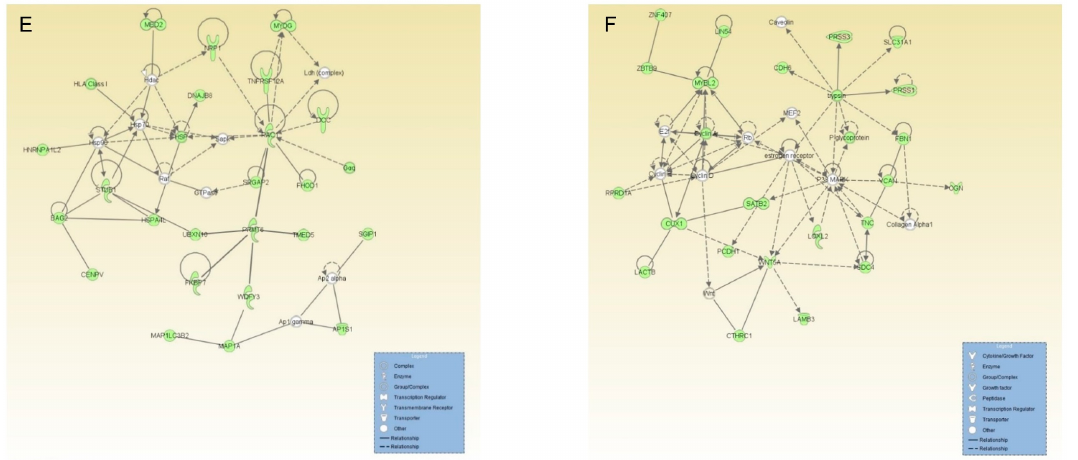
Figure 3. The SHED-specific proteome derived from nano-LC-MS/MS technology utilization. ( A ) Classification of the identified by nano-LC-MS/MS proteins that were exclusively expressed in SHEDs, using their role in general “Biological Processes” as the major criterion for bioinformatics clustering. The Gene Ontology (GO) sub-routine of DAVID software was the bioinformatics protocol applied. p < 0.05. ( B ) Heat map of the SHED-specific proteomic list, illustrating 137 proteins involved in cellular movement, migration and invasion. This SHED-specific heat map was created by using IPA. Each legend denotes respective function and p value: 1, Cell movement (8.211); 2, Cell movement of embryonic cell lines (6.478); 3, Cell movement of epithelial cell lines (6.418); 4, Cell movement of kidney cell lines (5.962); 5, Cell movement of endothelial cells (5.696); 6, Cell movement of tumor cell lines (5.102); 7, Cell movement of leukocytes (4.451); 8, Cell movement of blood cells (4.388); 9, Cell movement of phagocytes (3.902); 10, Cell movement of neutrophils (3.896); 11, Cell movement of cancer cells (3.757); 12, Cell movement of myeloid cells (3.647); 13, Cell movement of granulocytes (3.249); 14, Cell movement of tumor cells (3.145); 15, Cell movement of mononuclear leukocytes (2.801); 16, Cell movement of chondrocytes (2.784); 17, Cell movement of glioma cells (3.201); 18, Cell movement of macrophage cancer cell lines (2.874); 19, Cell movement of monocytes (2.676); 20, Cell movement of leukocyte cell lines (2.648); 21, Migration of cells (7.910); 22, Migration of endothelial cells (5.535); 23, Migration of embryonic cell lines (5.100); 24, Migration of kidney cell lines (5.067); 25, Migration of tumor cell lines (4.706); 26, Migration of epithelial cell lines (4.242); 27, Migration of blood cells (4.197); 28, Migration of phagocytes (4.149); 29, Migration of tumor cells (4.085); 30, Migration of leukocyte cell lines (3.255); 31, Migration of projection neurons (3.254); 32, Leukocyte migration (3.931); 33, Migration of granulocytes (3.197); 34, Migration of myeloid cells (2.690); 35, Migration of eosinophils (2.774); 36, Migration of heart cells (2.609); 37, Invasion of cells (6.638); 38, Invasion of tumor cell lines (4.865); 39, Invasion of tumor cells (4.447); 40, Invasion of cancer cells (2.759); 41, Cellular infiltration (3.085); 42, Cellular infiltration of blood cells (2.948); 43, Cellular infiltration of leukocytes (2.645); 44, Cell spreading (4.060); 45, Guidance of axons (2.997); 46, Homing of cells (3.348); 47, Homing of blood cells (2.823); 48, Movement of macrophage cancer cell lines (2.829). ( C ) Representative light-microscopy images of time lapses of cell monolayer-scratch wounds, at 0, 5 and 10 h post-scratch. Magnification: 10×. ( D ) Graphical presentation of the wound-healing (closure) percentage (%), at 0, 5, 10 and 12 h, following scratch formation. Data shown are means ± SEM. ( E ) Gaq-, Raf-, STUB1-, RAC1- and PRMT6-dependent molecular network. ( F ) Trypsin-, WNT5A- and Cyclin-A/D/E-dependent protein-interaction network. Protein molecules identified by our analysis are shown in green color, whereas the ones missing from the list (but still belonging to the IPA networks) remain uncolored.